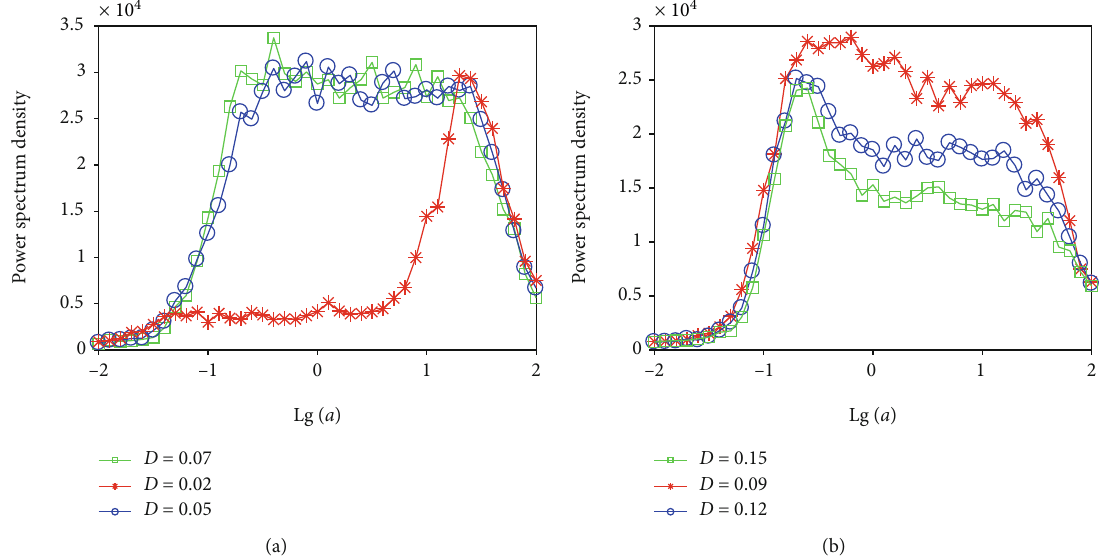
Figure 5: The relationship between lg ð a Þ and system output of undamped bistable system driven by asymmetric dichotomou s noise. (a) The output when input white noise intensity is D = 0 : 02 , 0.05, and 0.07. (b) The output when input white noise intensity is D = 0 : 09 , 0.12, and